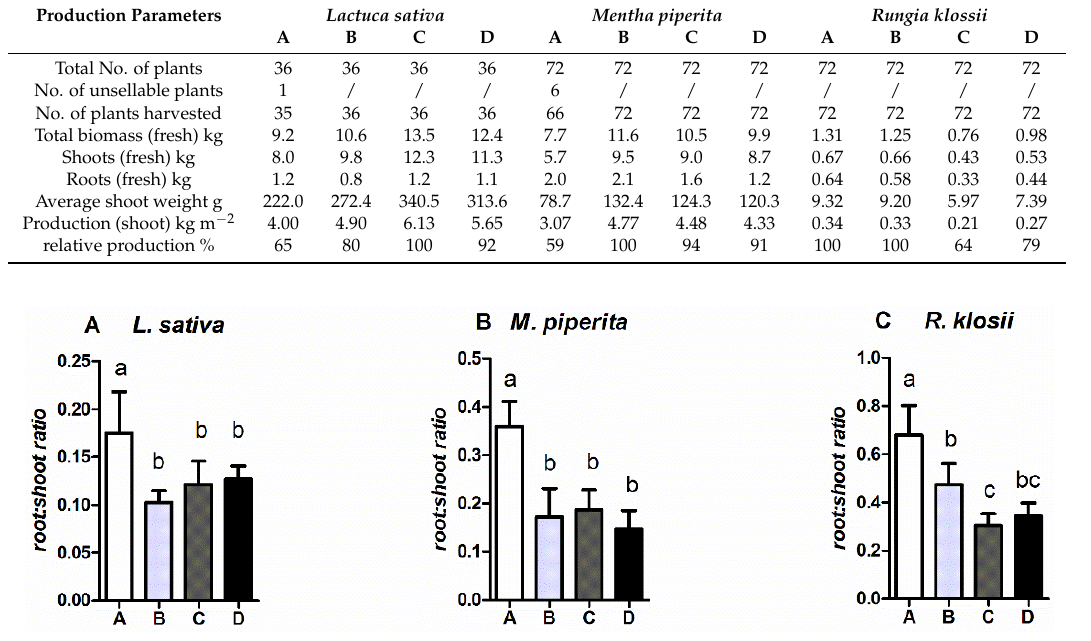
Figure 3. Root-to-shoot ratio in lettuce, mint, and mushroom herb in all four systems. Values are means ± SD. Different lower-case letters indicate significant differences (p < 0.05 ) ; n = 6.